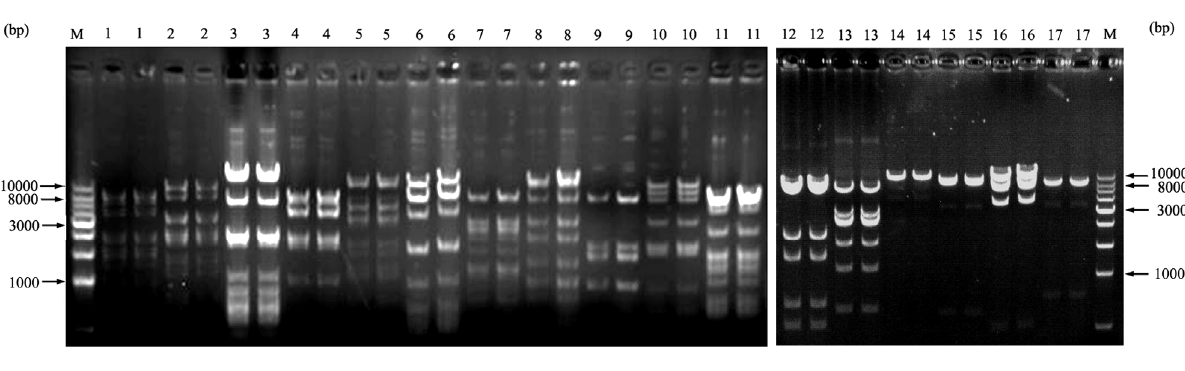
Figure 4. Examination of the BAC colony stability. M was 1 kb DNA Ladder; lanes 1–11 were restrictive finger print of different BAC clones from blood cell and 12–17 from fibroblast cells in second electrophoresis; Every clones has two electrophoretic bands, the first was at day 1 and the second was at day